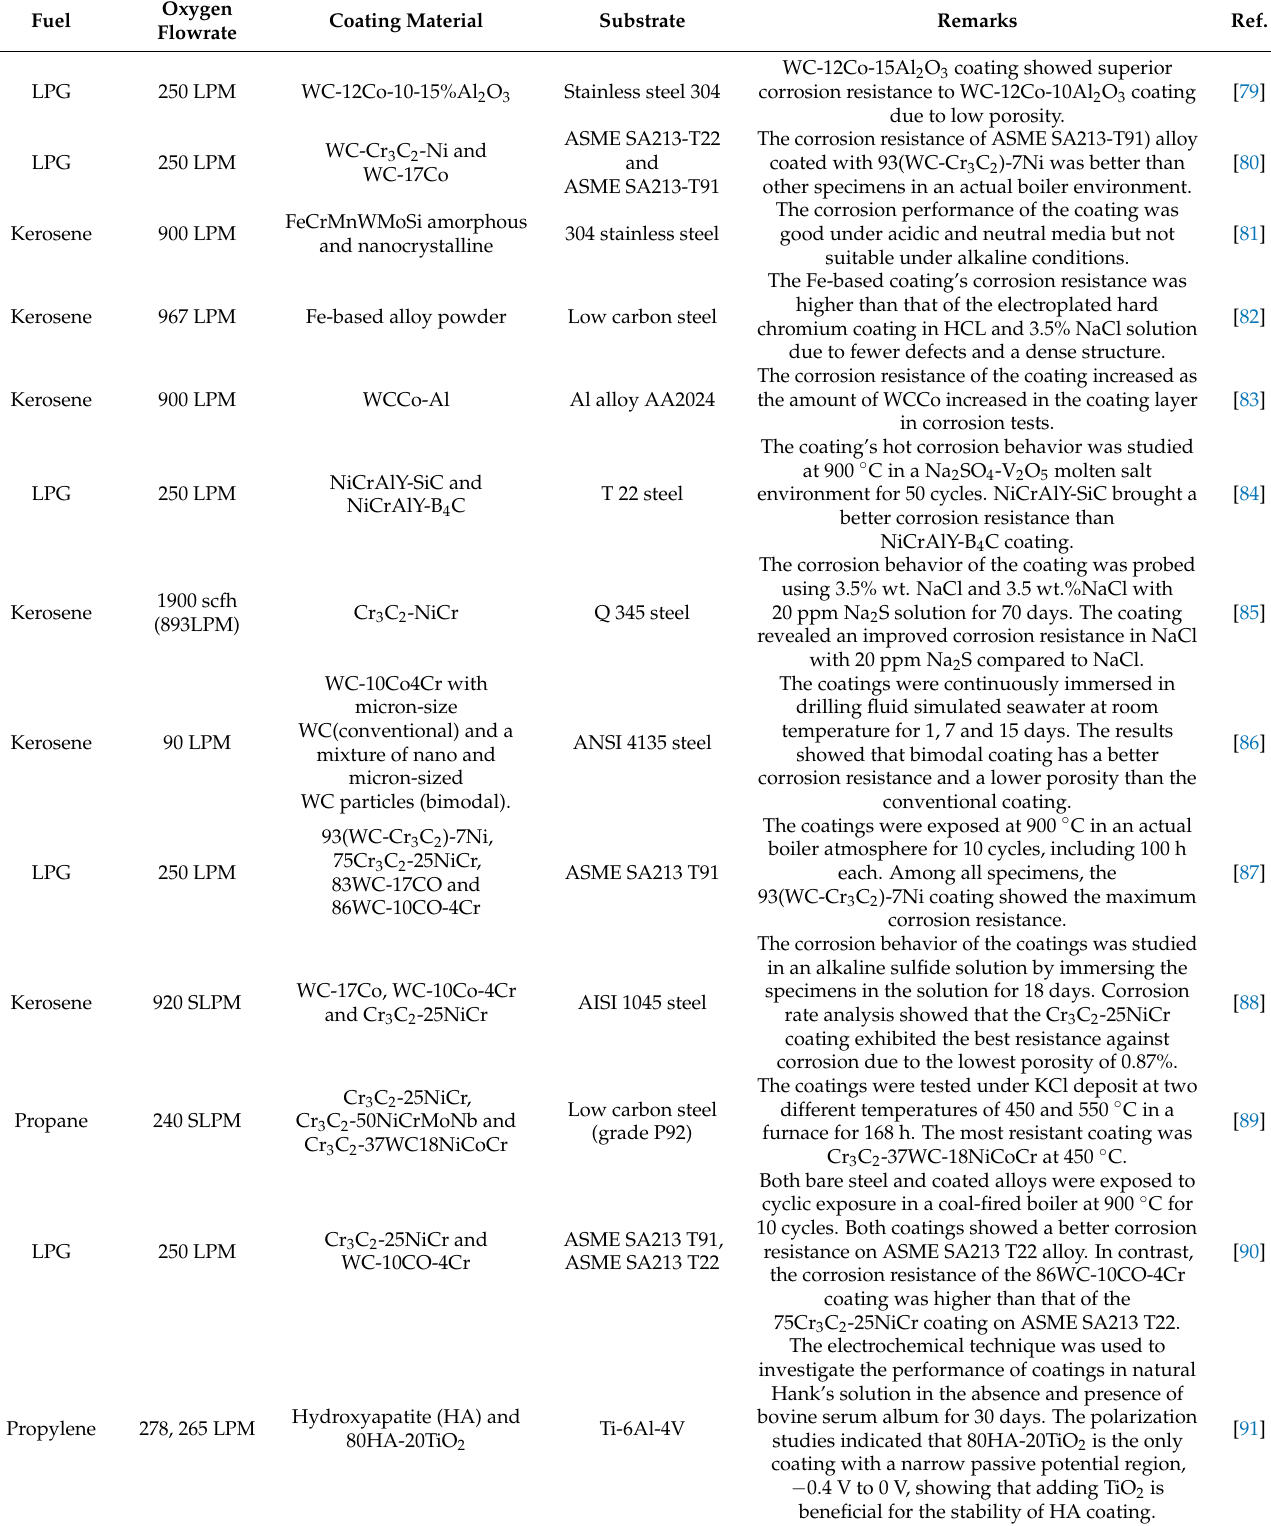
Table 1. Summary of coating materials and oxygen flow rates used in